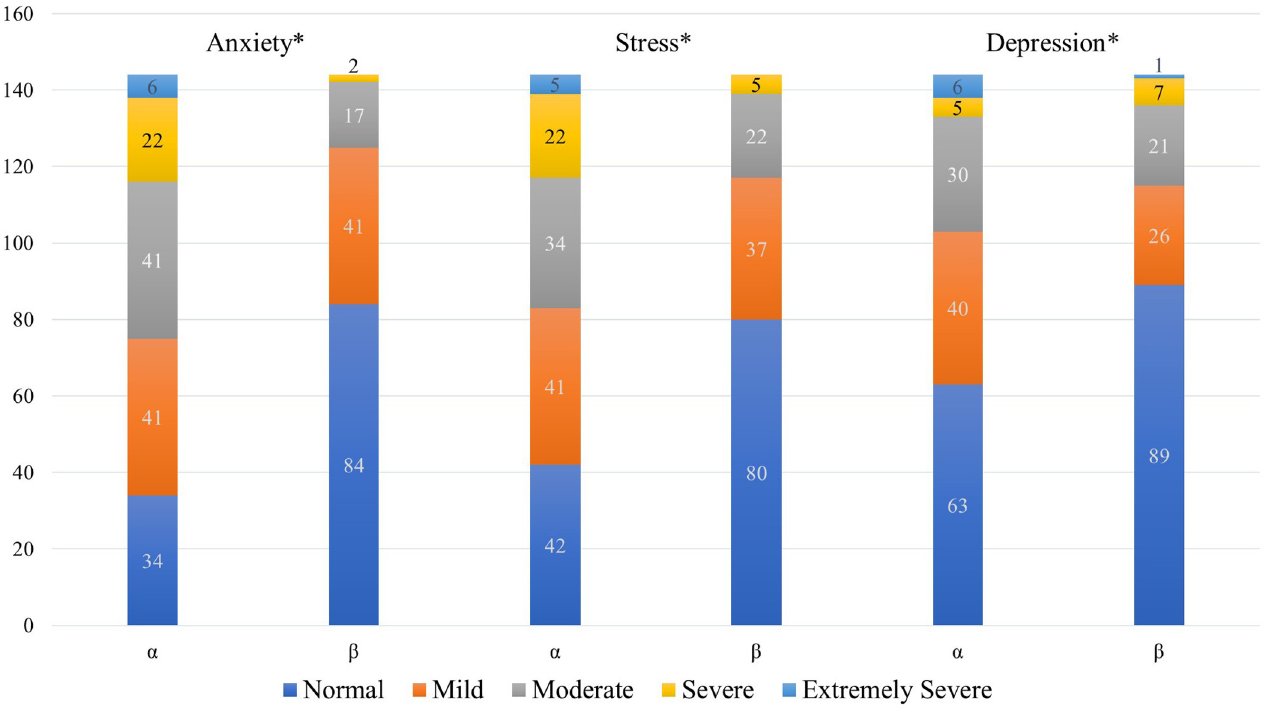
Fig 1. Subjective ratings of level of anxiety, stress, and depression when COVID-19 was first discovered (retrospective rating) and after COVID- 19-Pandemic restrictions were lifted.